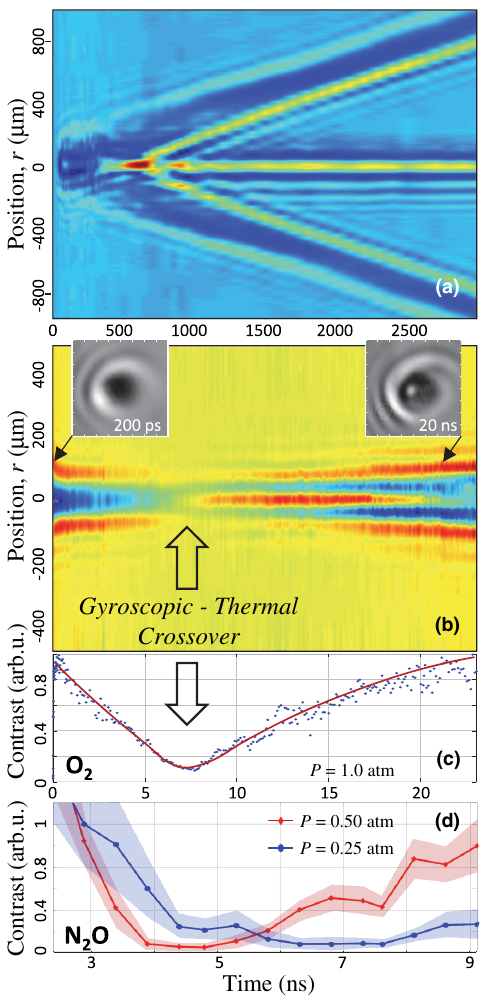
FIG. 2. Radial cross section of images recorded along the centrifuge beam [as in Fig. 1(b)] in 1 atm of oxygen as a function of the delay time between the centrifuge and probe pulses. The long time scan in panel (a), carried out with ns probe pulses, extends to 3 μ s and shows an acoustic wave traveling with the speed of sound away from the central core (see Movie 1 in Ref. [30]). In panel (b), we zoom in on the first 23 nanoseconds (by switching to ps probe pulses) and find a crossover between the rotation-induced and thermal channels around 7 ns, when the image contrast vanishes almost entirely. Sample images of both refractive channels are shown in the square insets. The crossover is quantified by calculating the change in the image contrast and plotted in panel (c). The red line on top of the experimental data points is shown to guide the eye. Evidence of the same crossover in the gas of N 2 O molecules at two different pressures of 0.5 and 0.25 atm is shown in panel (d) by red and blue lines, respectively. Shaded regions around each line represent the statistical error (1 standard deviation) in our experimental